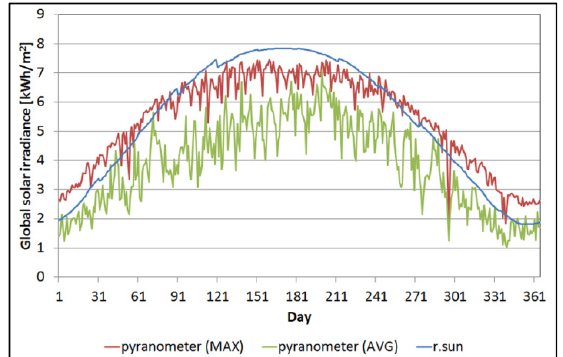
Figure 6: Daily values of maximum, average global irradiance flux (red and green, respectively) and r.sun global irradiance values (blue), at the pyranometer